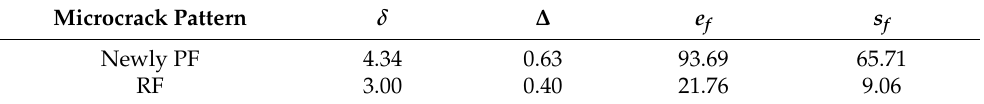
Figure 7. Length frequency histogram of the microcracks on the RF. ( a ) Relative frequency. ( b ) Cumulative frequency. Table 2. Parameters of fitted lognormal distributions of the microcrack lengths.